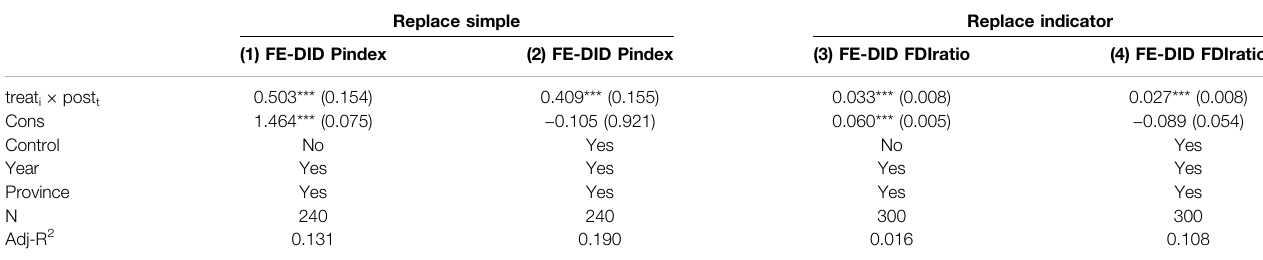
TABLE 4 | Robustness test. Replace simple Replace indicator